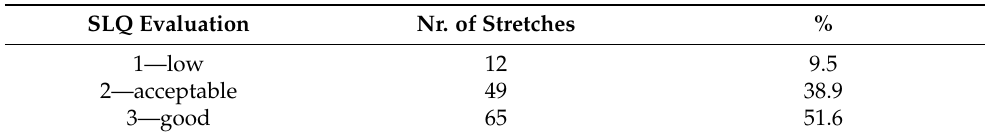
Table 10. Street light quality (SLQ).